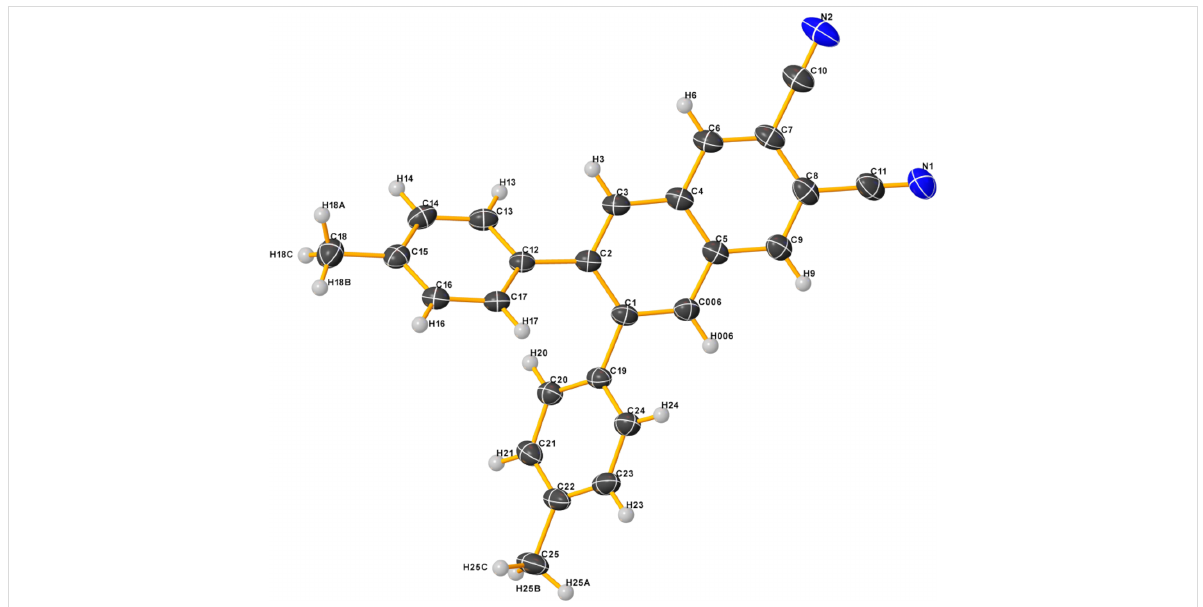
Figure 1: Molecular structure in the crystal of Me as obtained by X-ray diffractometric analysis. Thermal displacement ellipsoids are shown with 50% probability. Color code: black = carbon, grey = hydrogen and blue = nitrogen.